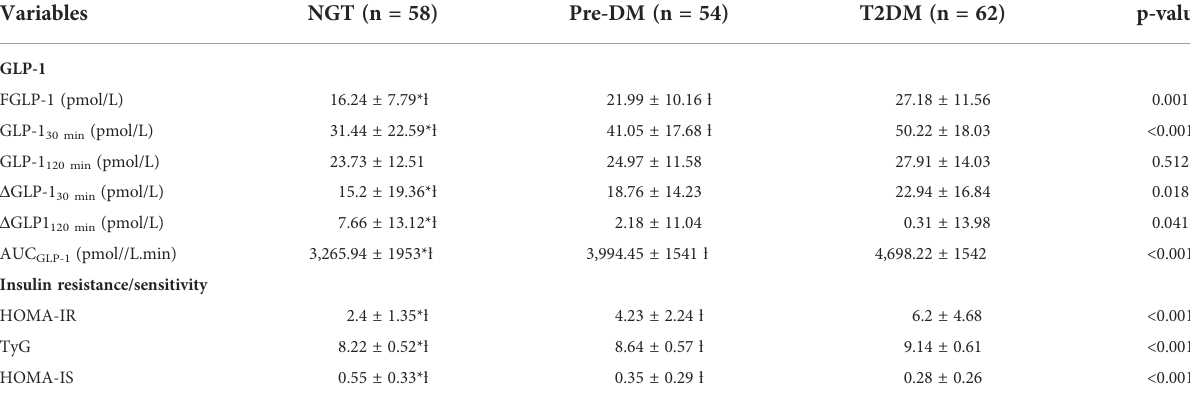
TABLE 3 Comparisons of total GLP-1 levels, insulin resistance, and insulin sensitivity indices in NGT, pre-DM, and T2DM. Variables